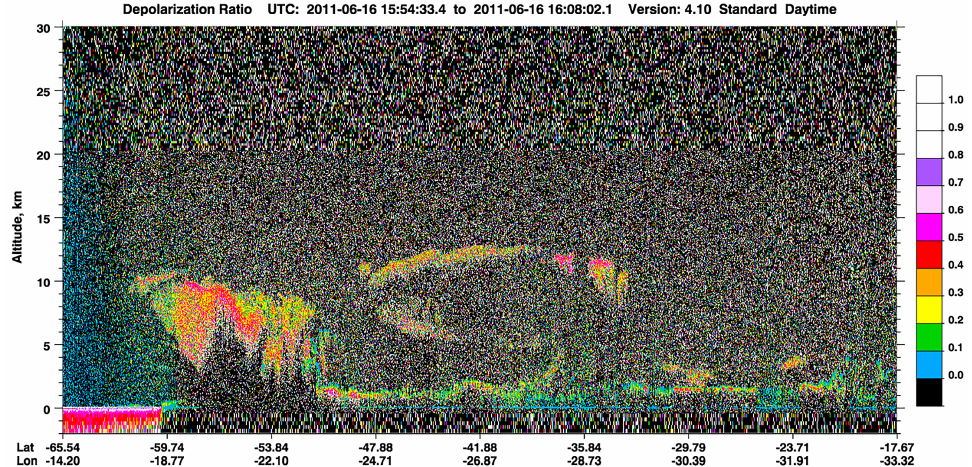
Figure 4. Image of CALIOP depolarization ratio at 532 nm from 15:54–16:08 UTC on 16 June 2011 for the Puyehue–Cordón Caulle eruption [37].